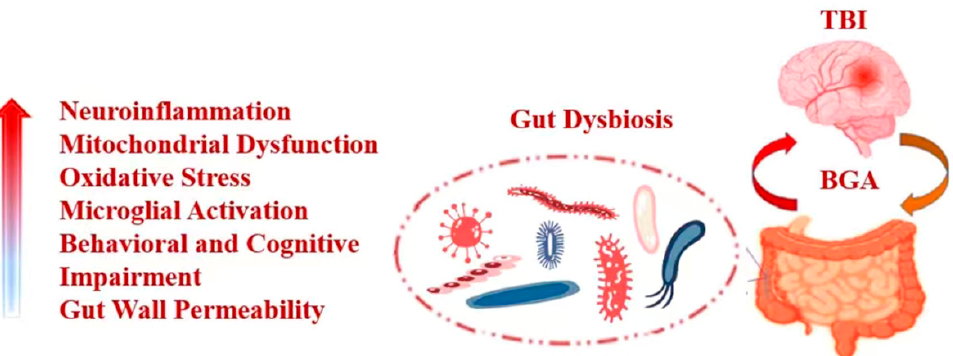
Figure 3. TBI caused dysbiosis through the BGA and its negative feedback